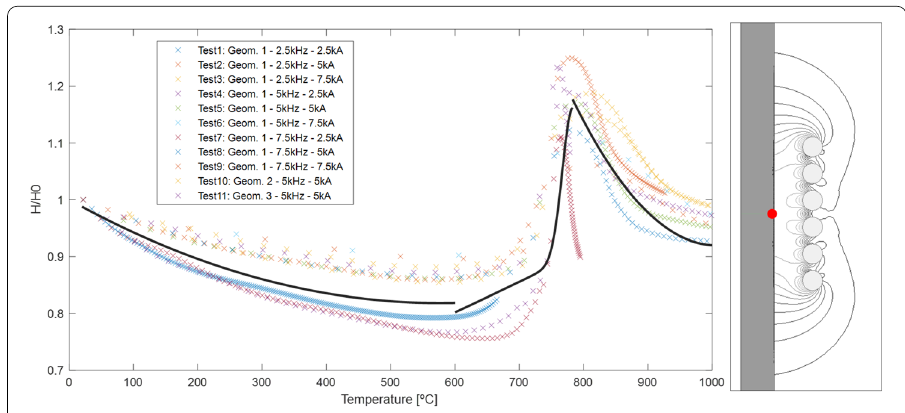
Fig. 5 Normalized magnetic field strength vs. temperature for various geometries, frequencies and current intensities with fitted Thermal Modifier in solid black line (right) computed in the central point marked in red (left). Note: The reader is referred to the web version of this paper for interpretation of the references in